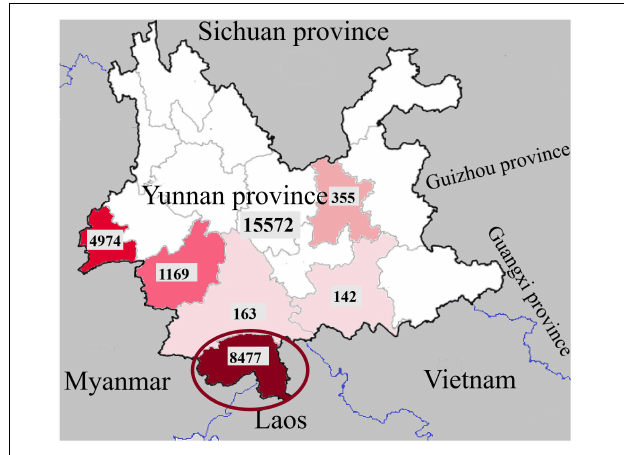
FIGURE 1 | Regional distribution of dengue fever cases in Yunnan Province, China, 2013-2019 (the dates in the picture are from Zhang, 2021).